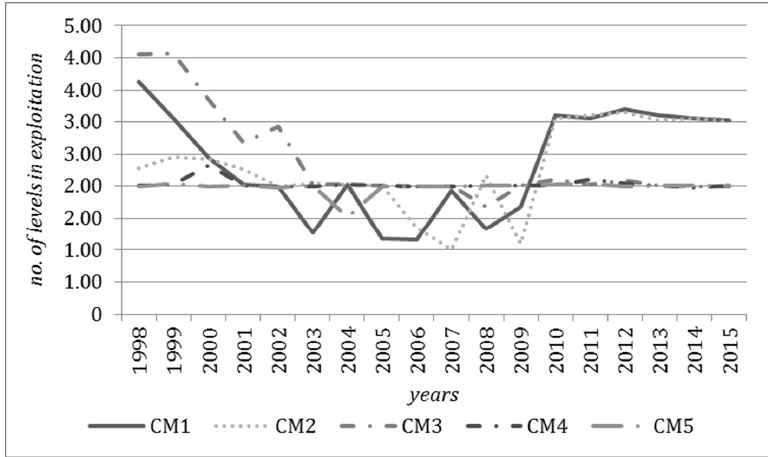
Figure 11. Number of levels in exploitation in examined hard coalmines over the period 1998–2015. Source: own work. Energies 2017 , 10 , 1480 13 of 22